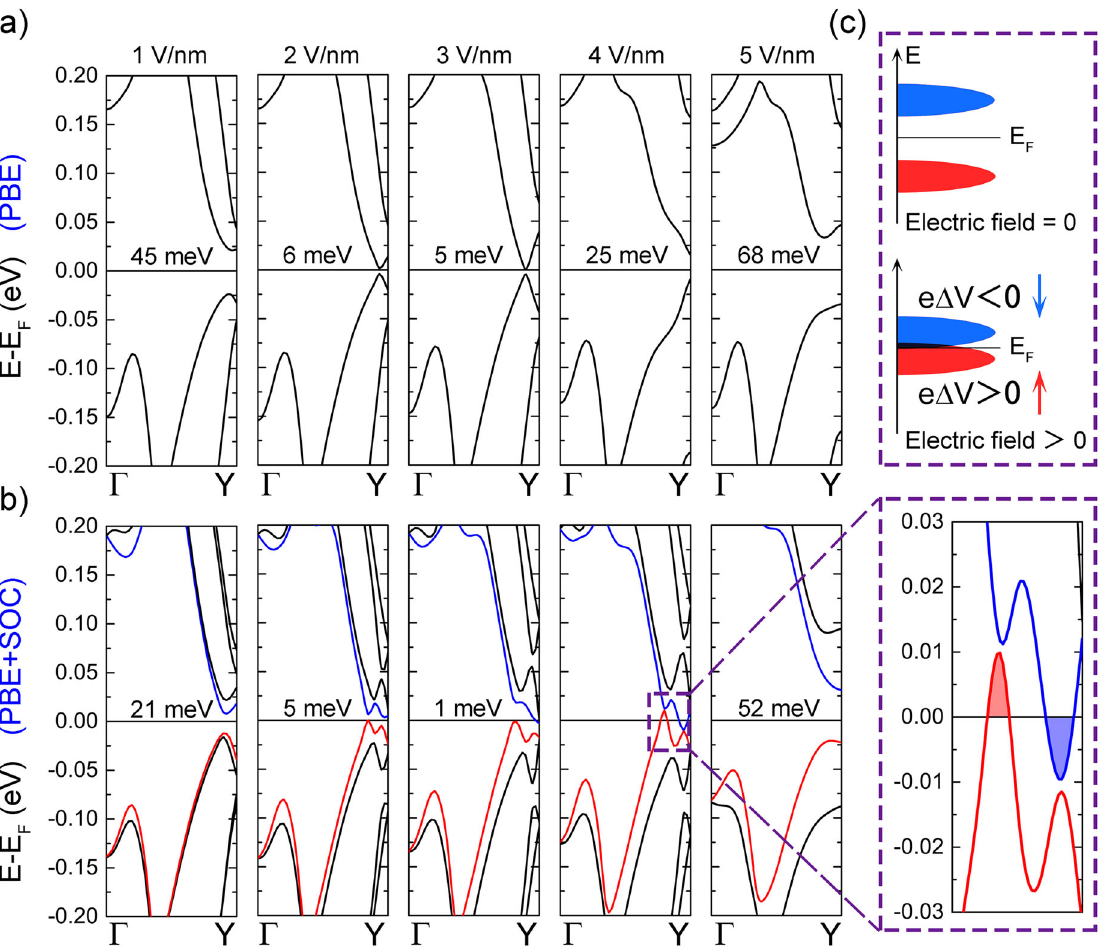
Fig. 5 Band structure of aW-zSbNR with respect to electric fi eld without ( a ) and with ( b ) SOC. c Schematic DOS diagram of aW-zSbNR with and without an in-plane electric fi